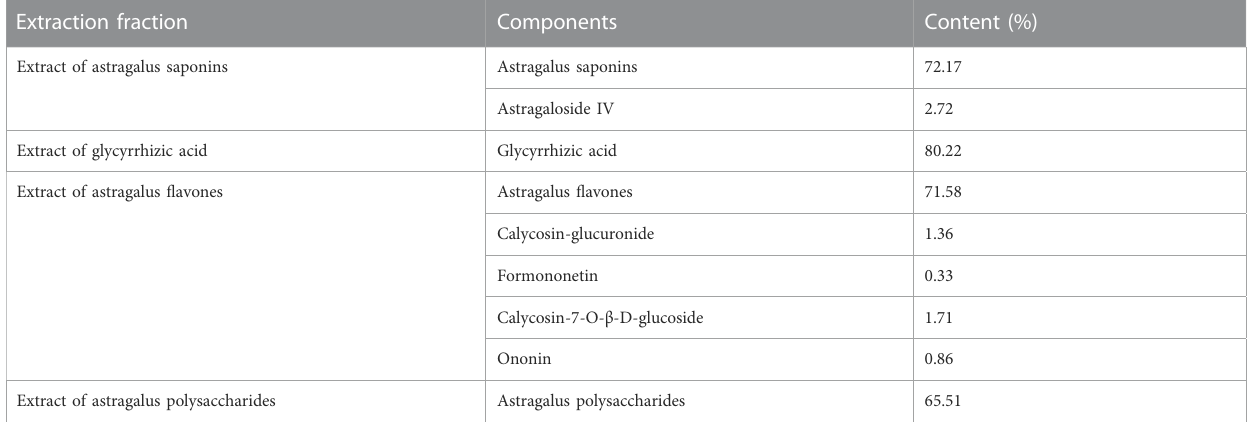
TABLE 1 Content of each component extracted from three batches of Astragalus and Glycyrrhizae . Extraction fraction